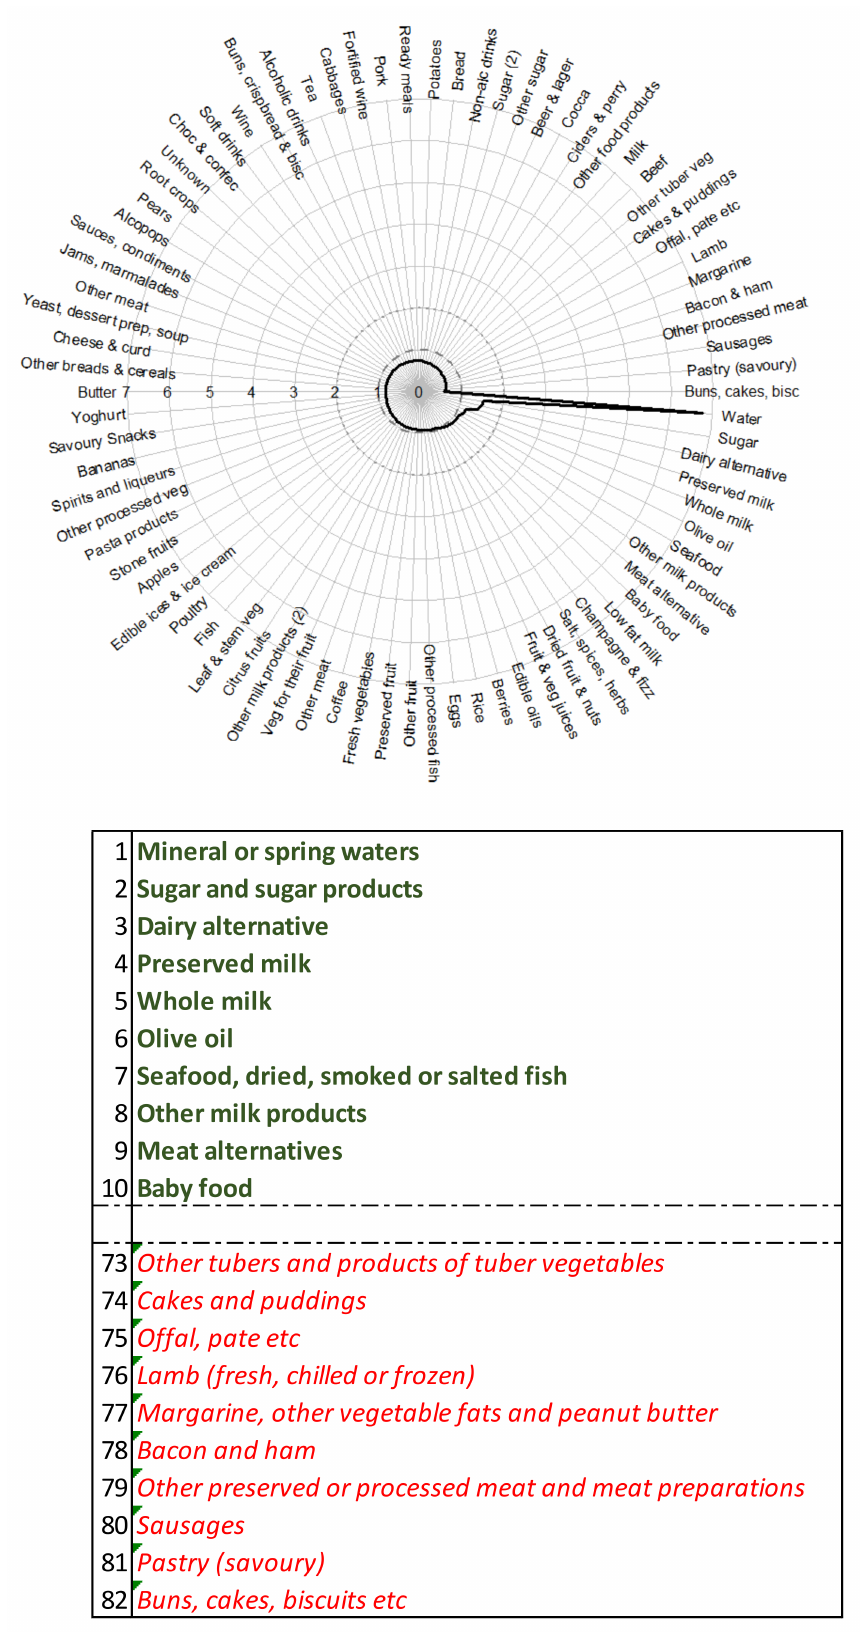
Figure A4. Hydrators ( n =